Question: Does the plotted quantity increase or decrease?
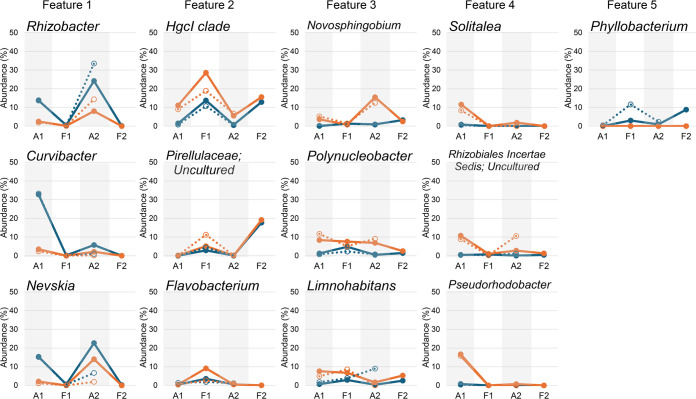
Answer: increasing